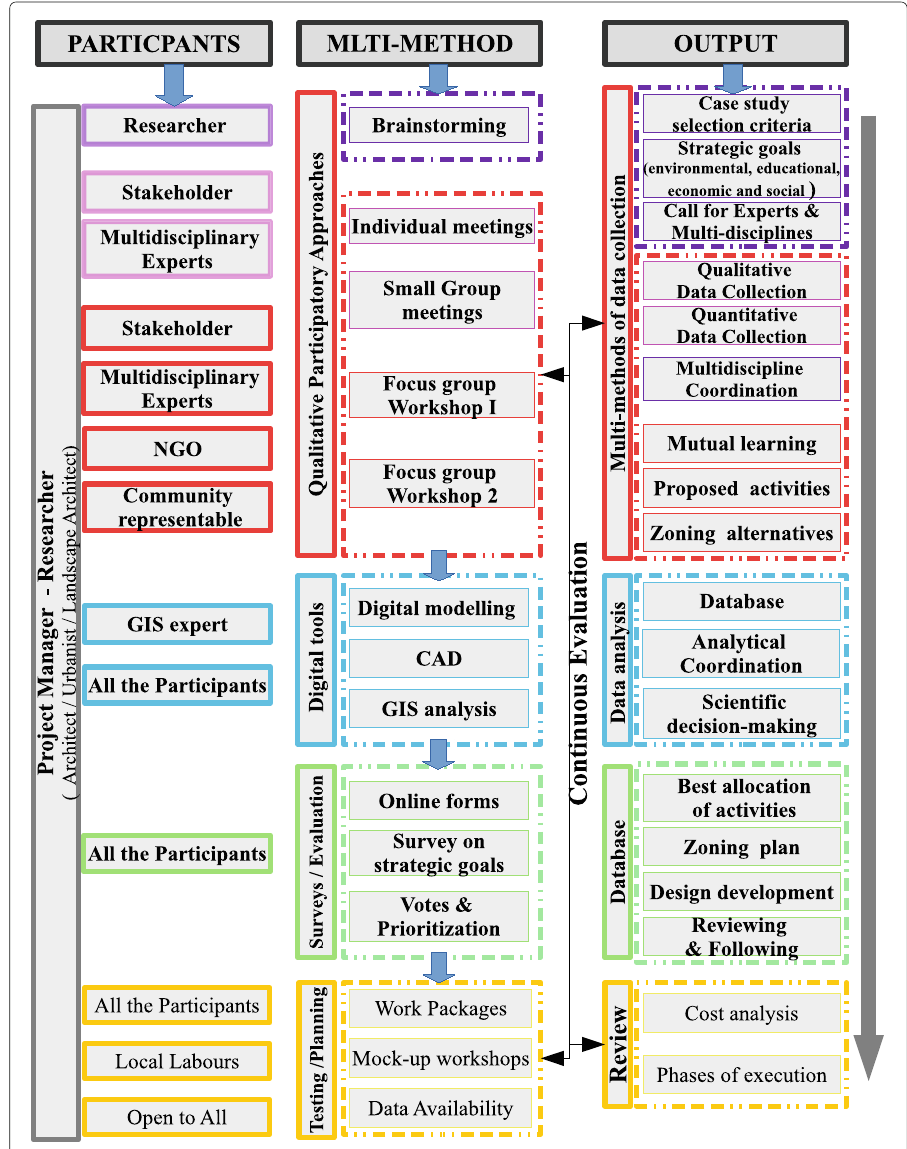
Fig. 5 The eco-landscape integrative multi-methods framework